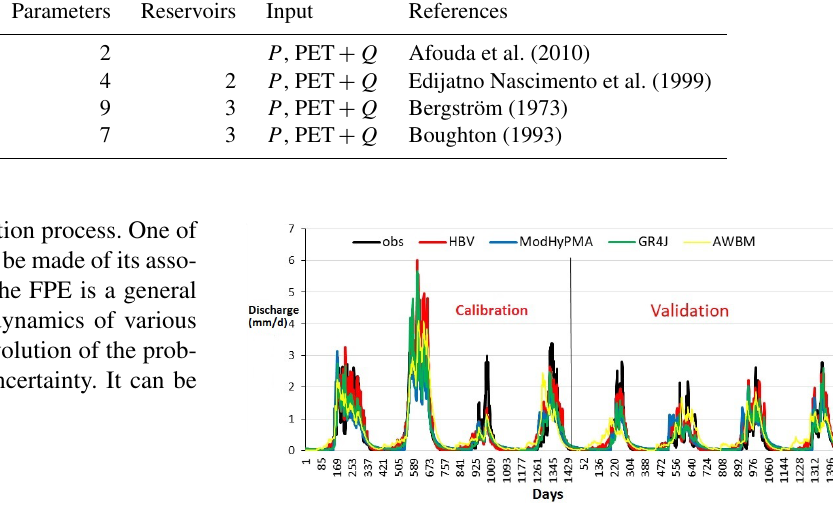
Figure 2. Calibration and validation of the investigated models in the Mono basin at Athiémé.